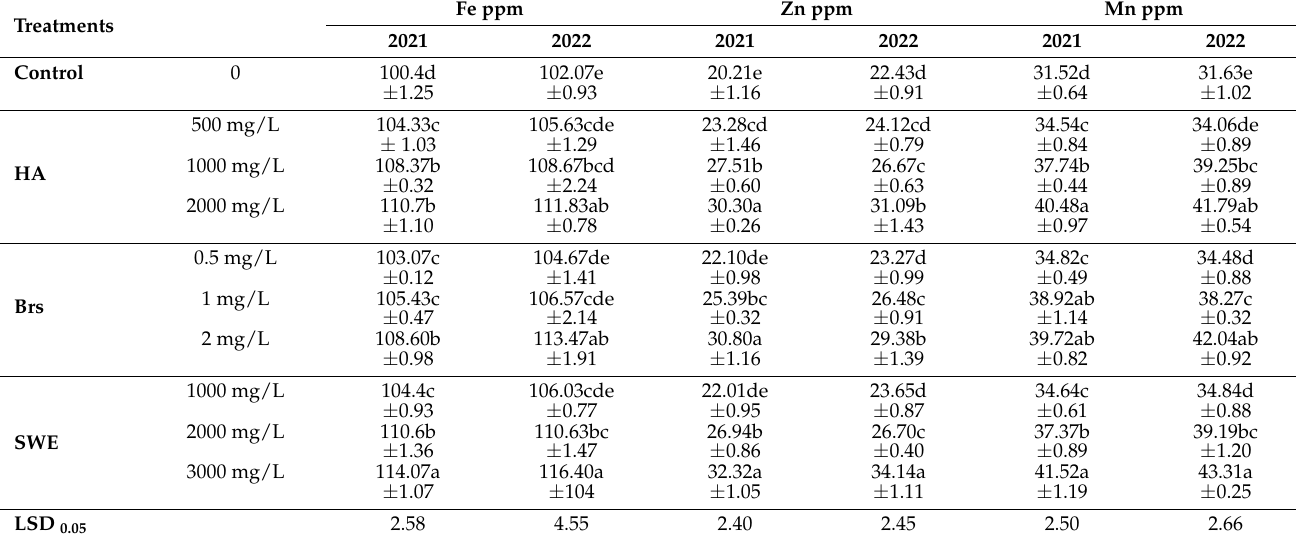
Table 10. Effect of foliar spraying of HA, Brs, and SWE on the leaf mineral content of micronutrients of apricot cv. Canino during